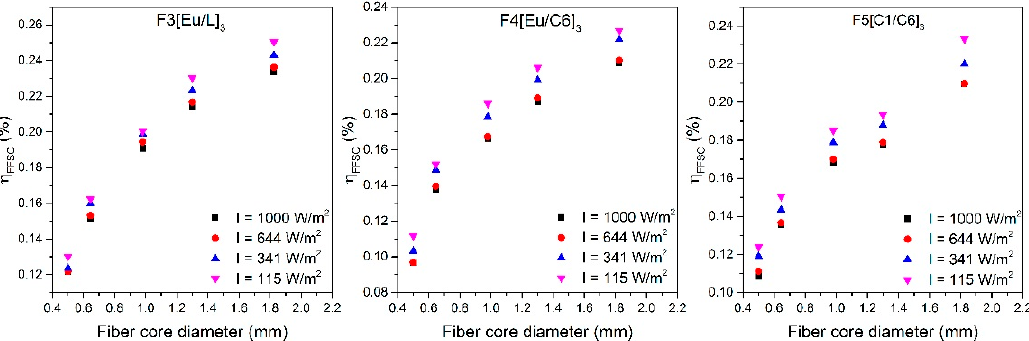
Figure 7. Evolution of the η FFSC of the three double-doped combinations for different weather scenarios as a function of the fiber core diameter. The illuminated fiber length is 4.5 cm in all cases.